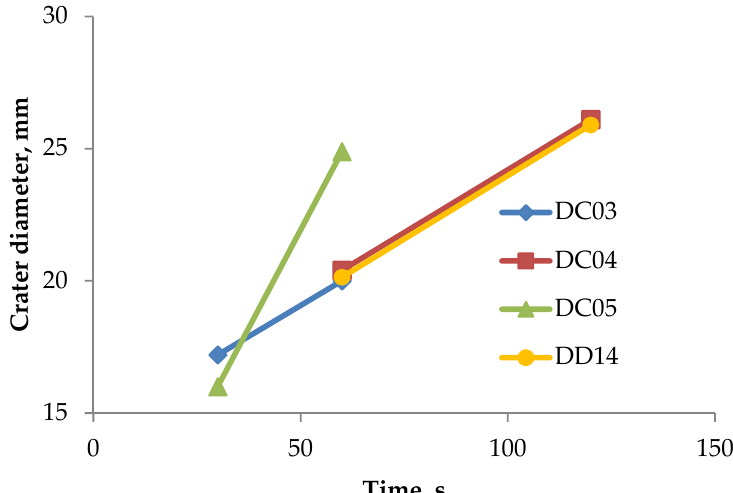
Figure 8. Crater depths in the investigated samples.